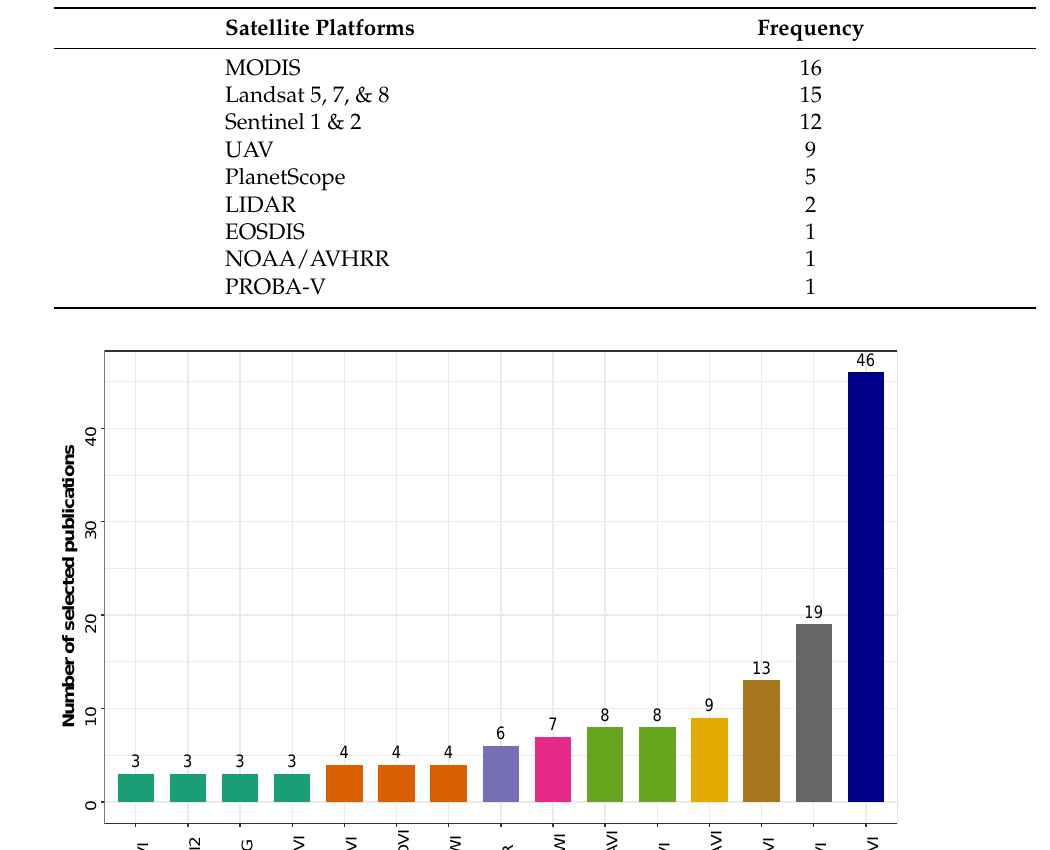
Table 3. Distribution of satellite platforms found in the selected literature.